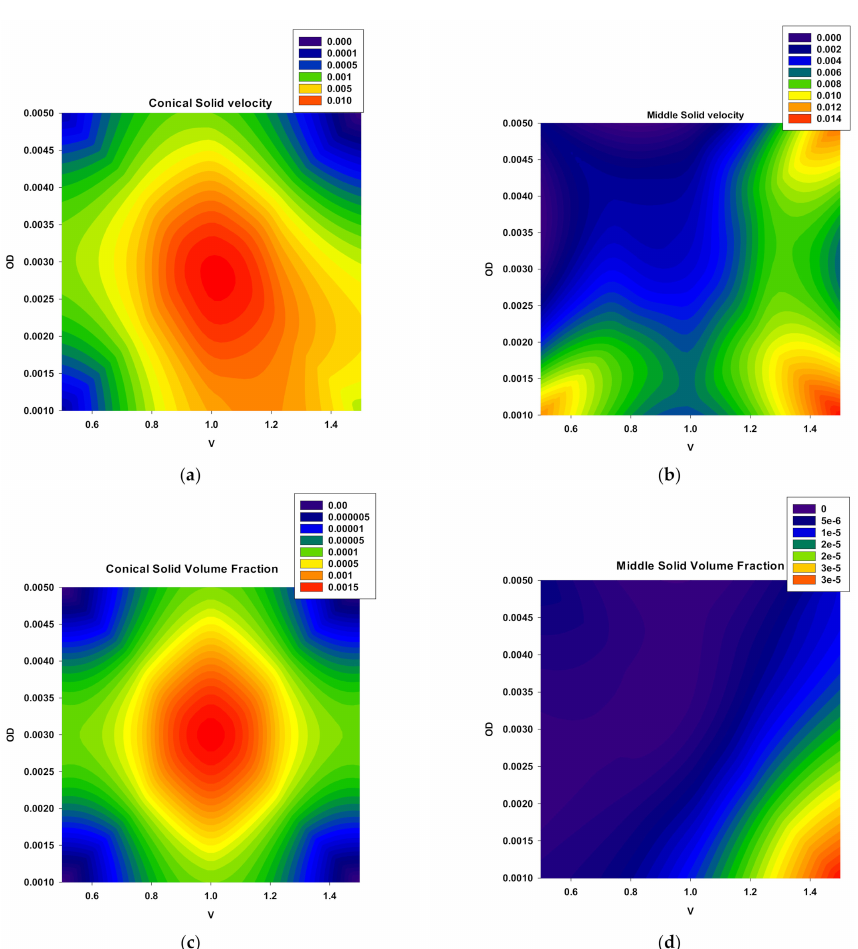
Figure 8. ( a , b ) average middle solid velocity and solid volume fraction ( c , d ) on 2D plots as a function of feed gas velocity and orifice diameter.